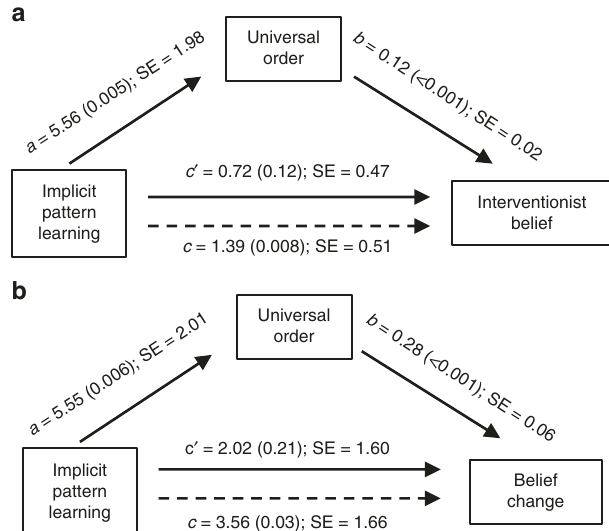
Fig. 3 Explicitly reported intuitions of universal order (UO) mediate effects of implicit pattern learning on belief. a IB and b belief change in the U.S. Sample. The in fl uence of implicit pattern learning on religious belief without (dashed lines) and with (solid line) UO as a regressor is shown. The model displays the unstandardized coef fi cients for each path, with P values indicated